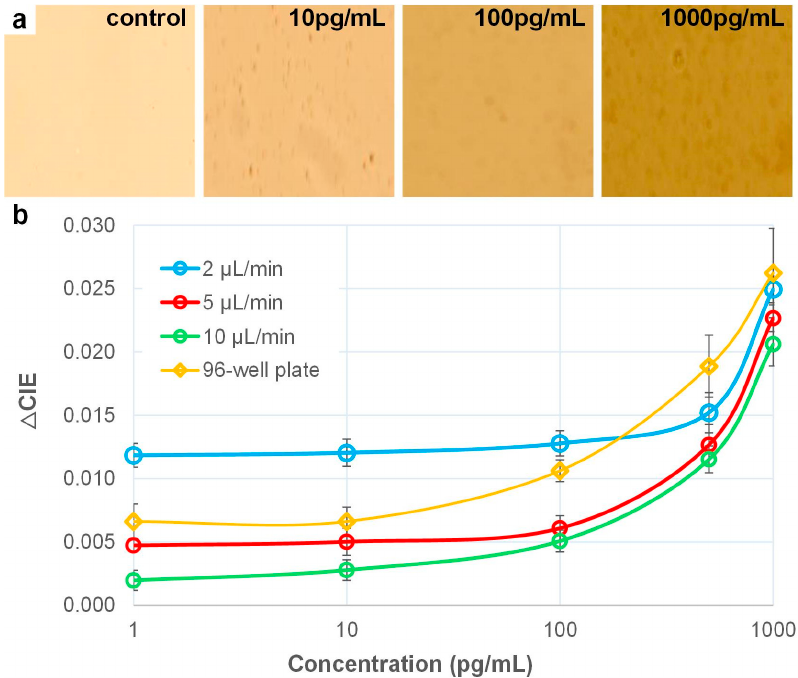
Figure 6. Results of on-chip and 96-well plate human IL-6 colorimetric ELISA using CIE color space analysis. ( a ) Colorimetric images of immunoassay in DMF platform at 100× magnification. Images were captured 5–10 min after the reaction was stopped. ( b ) Color signal as a function of IL-6 concentration. Differences in color are represented by the distance of shift of the mapped location in the color space relative to the mapped negative control ( ∆ CIE).